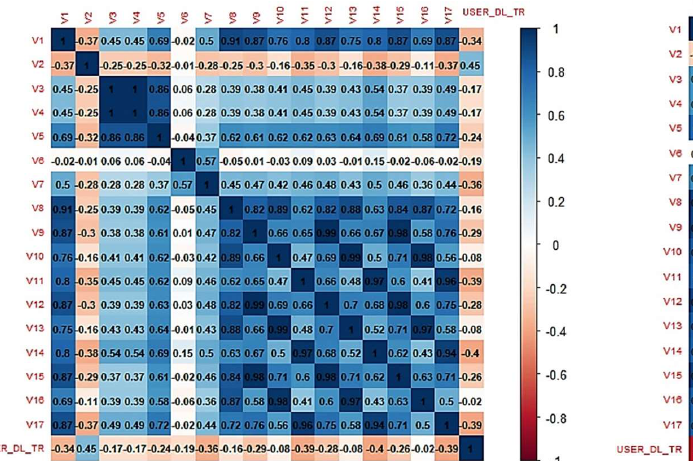
Figure 4. Matrix of Pearson correlation coefficients (correlogram) of research variables for the M9J P-J section.